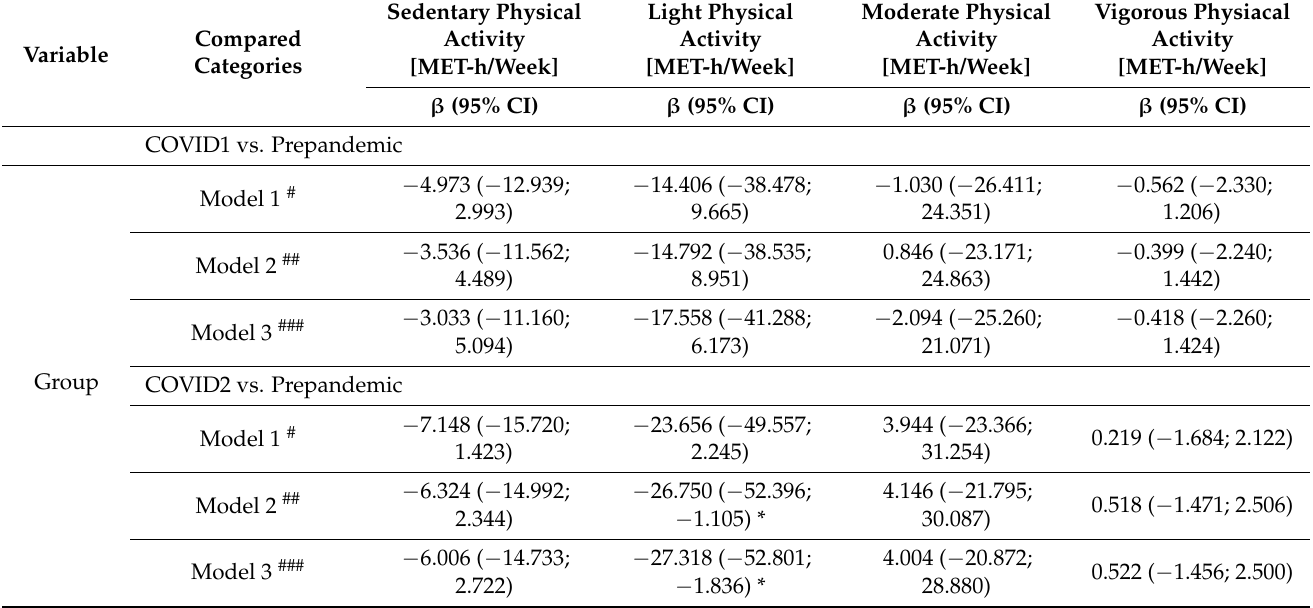
Table 6. Regression analysis—intensity of physical activity—women at risk of